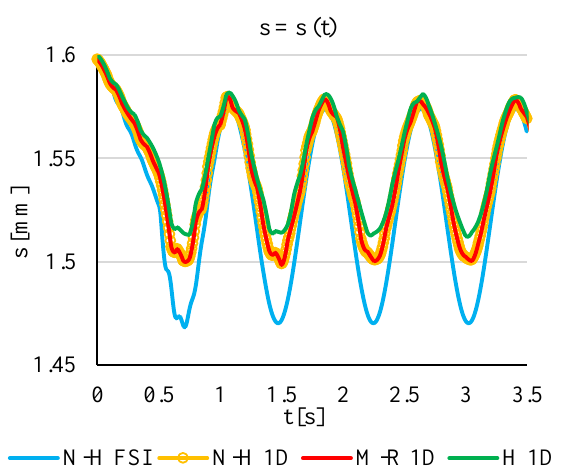
Fig. 10. Wall thicknesses s of the thin-walled tube. The wall thicknesses of the tube s are shown in Fig. 9 and Fig. 10 instead of the inner diameters of the tube d 1 ( D , 2r ). It may be surprising in the context of Fig. 7 and Fig. 9 that the largest changes in diameter d 2 and thickness s are represented by the neo-Hookean solid. However, this is due to the fact that the tube is pressure-loaded and, in negative stresses, the neo-Hookean solid shows a greater nonlinear stress-strain relationship than Mooney-Rivlin. The ANSYS FSI simulation has the highest accuracy compared to the experimental testing, followed by a one- dimensional model of Hookean material. The reasons explain the following values of radial, circumferential and axial stresses. Indexes 1 and 2 continue to distinguish the outer and inner surfaces of the tube. The static pressures p or radial stresses σ r1 are presented in the Fig. 11 and Fig. 12. Fig. 13-14 show circumferential stresses σ t1 , σ t2 and for the thin-walled material σ t .